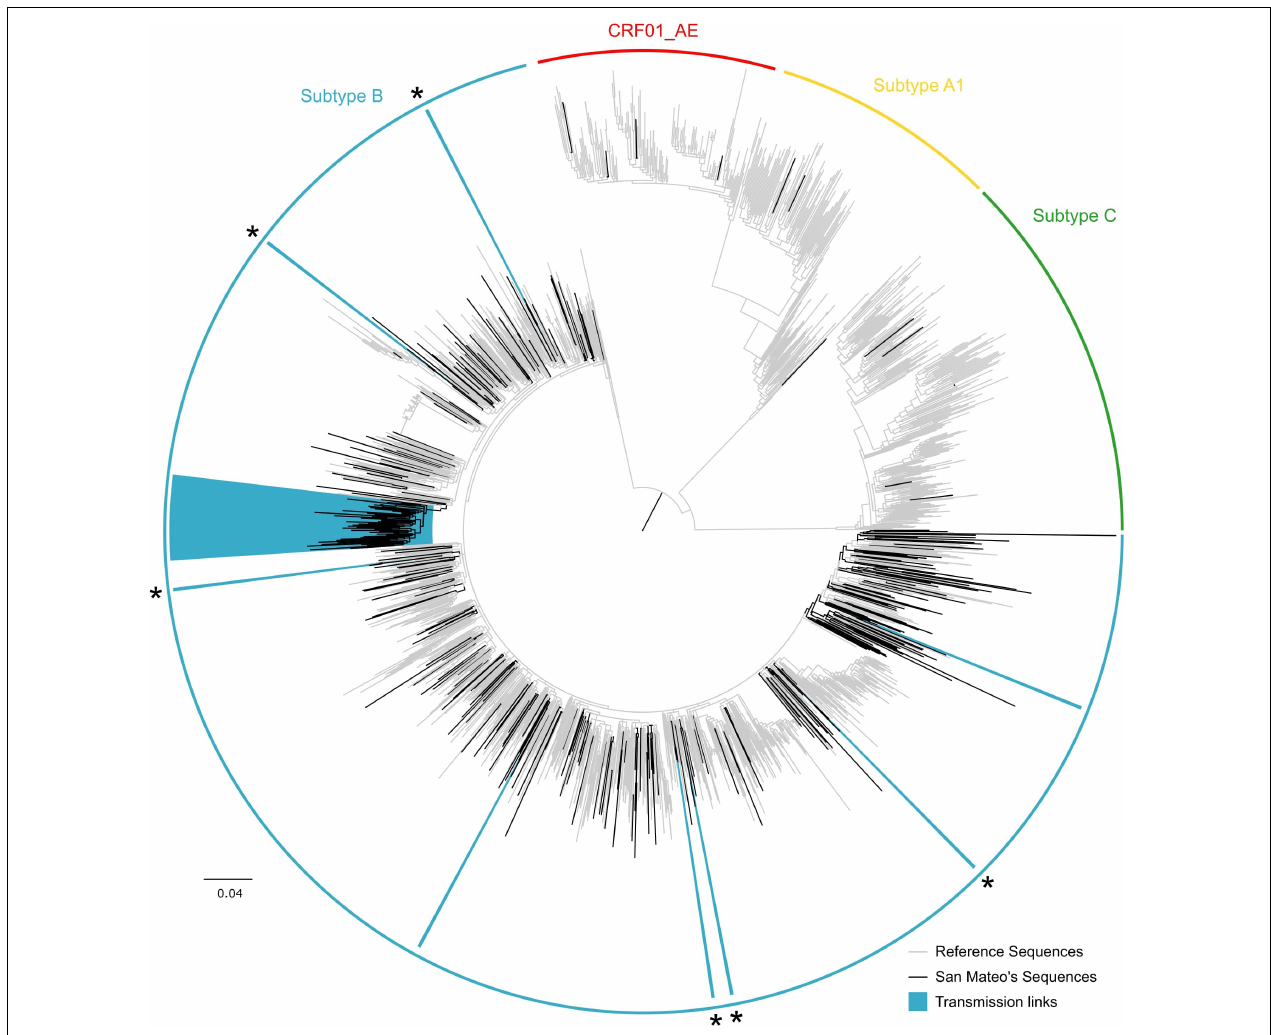
FIGURE 1 | Maximum likelihood HIV-1 pol transmission clusters in San Mateo County, California. Colored semi-circles indicate HIV subtypes. Black branches represent sequences obtained from 316 HIV-positive adults receiving antiretroviral treatment as part of the publicly funded San Mateo County AIDS Program. Gray branches denote reference sequences. Clades highlighted in blue indicate transmission clusters identified in Cluster Picker (TBE ≥ 90 and genetic distance threshold of 8%). Asterisks indicate transmission pairs mutually identified as transmission links in Cluster Picker and HIV-TRACE. The scale bar at the bottom represents the number of substitutions per site along branches in the tree